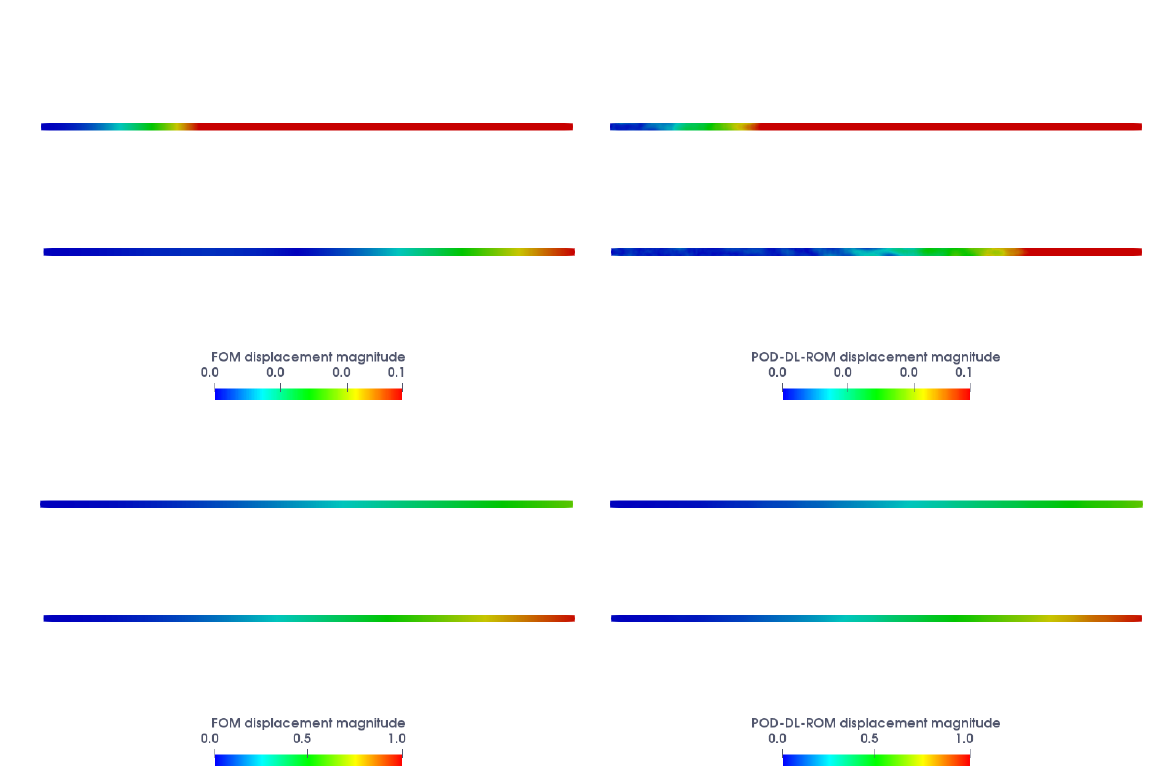
Figure 9. Test case 2: FOM ( left ) and POD-DL-ROM ( right ) structure displacement magnitudes for the testing-parameter = [ 2.3 × 10 6 g/(cm · s 2 ),0.325 ] at t = 2.3084 s and t = 2.64 s (rows 1–2) and µ instances µ test at t = 2.3084 s and t = 2.64 s (rows 3–4).